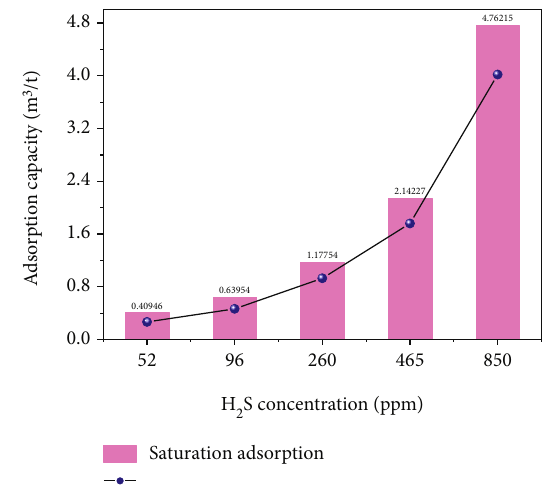
Figure 4: Relationship between H adsorption